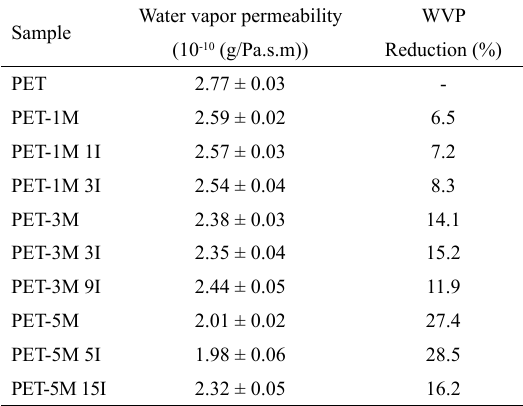
Table 5. Water vapor permeability (WVP) of the PET/o-Mt nanocomposites. Water vapor Sample